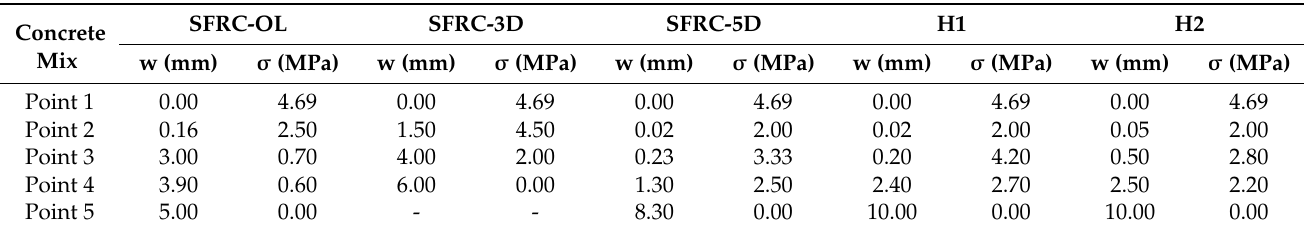
Table 6. Softening functions of the concrete mixes